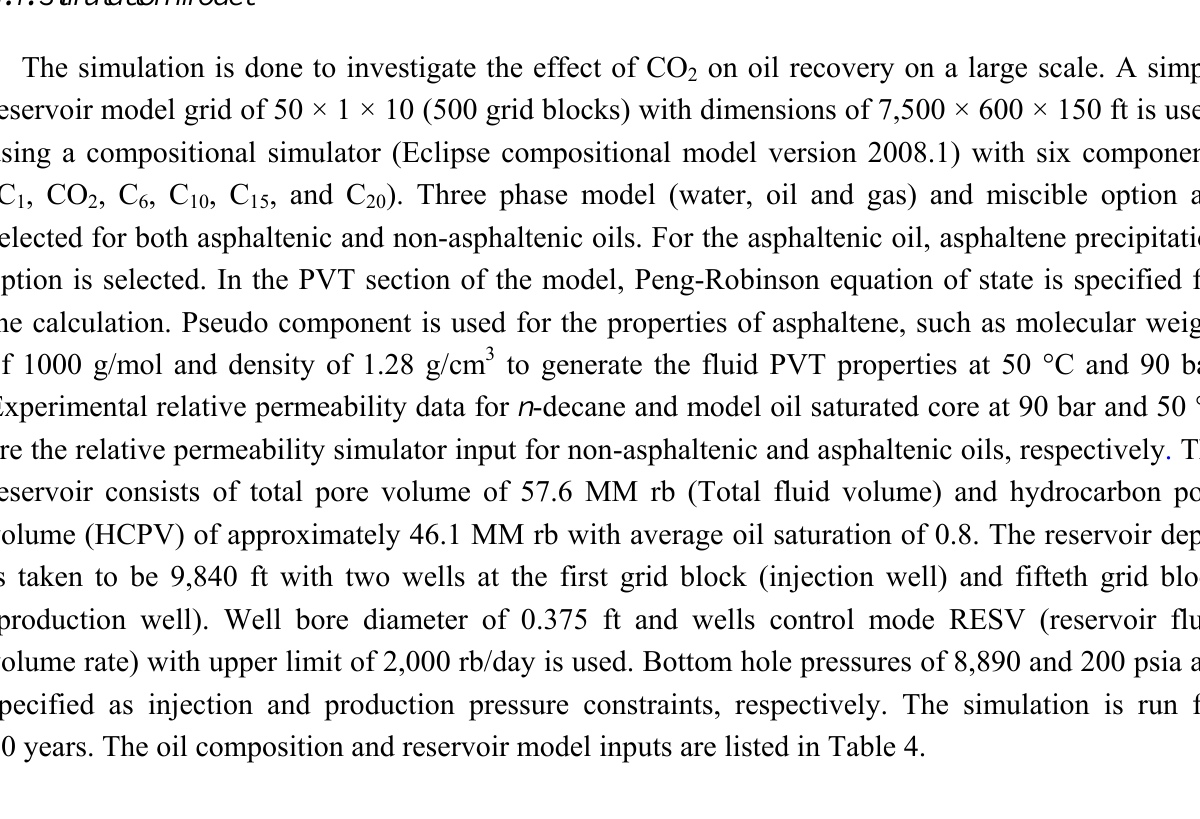
Table 4. Reservoir simulation input data and oil composition in mol